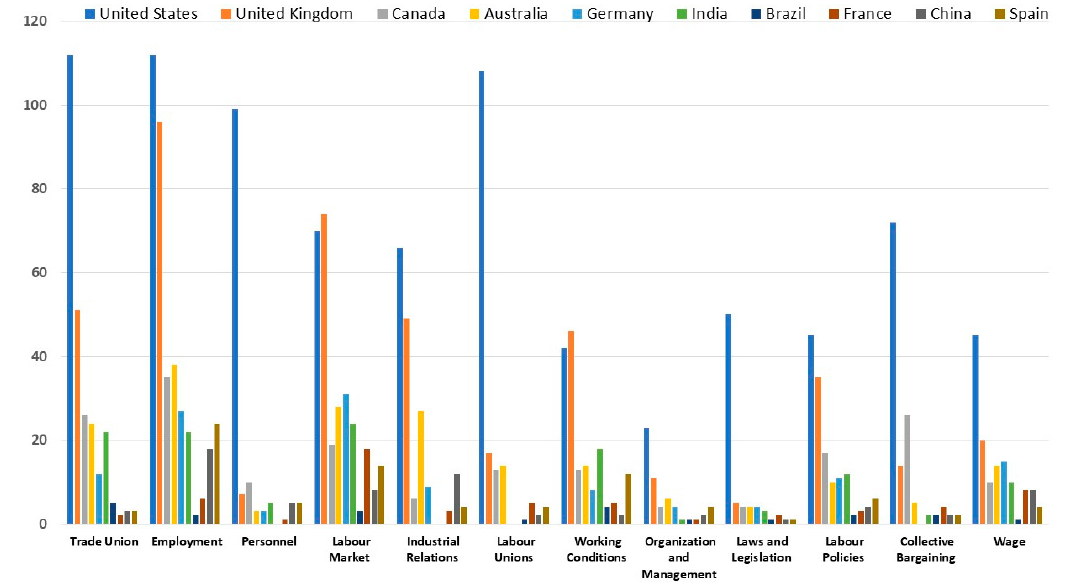
Figure 11. Main keywords by countries related to labour relations.